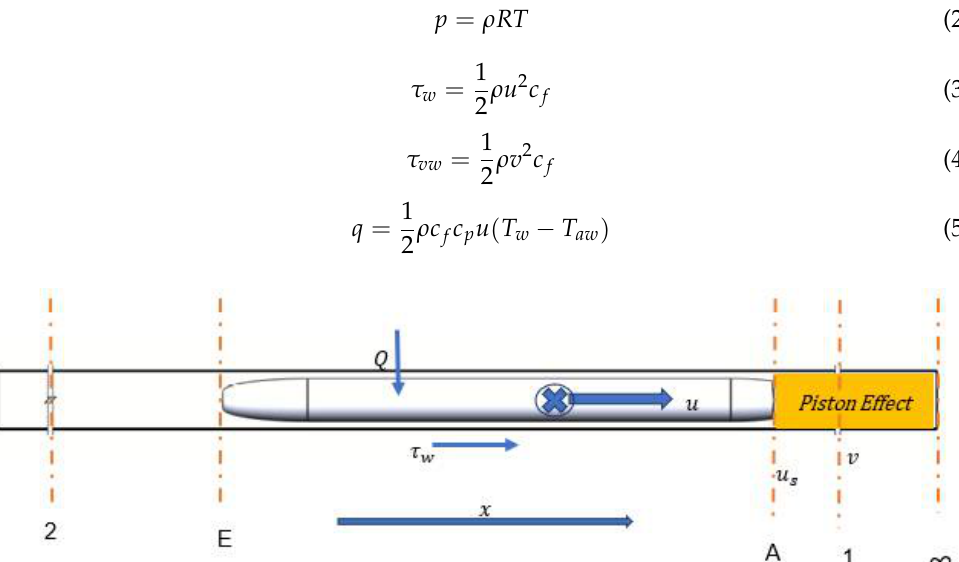
Figure 2. Sketch diagram for pod motion in a tube.